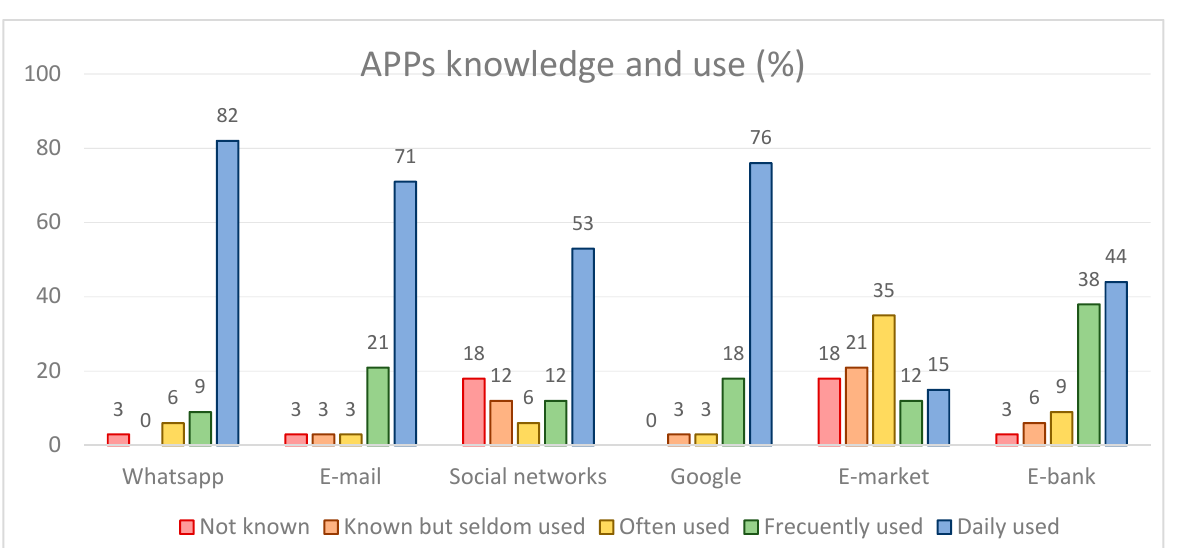
Figure 7. Degree of Knowledge and Use of the APPs.